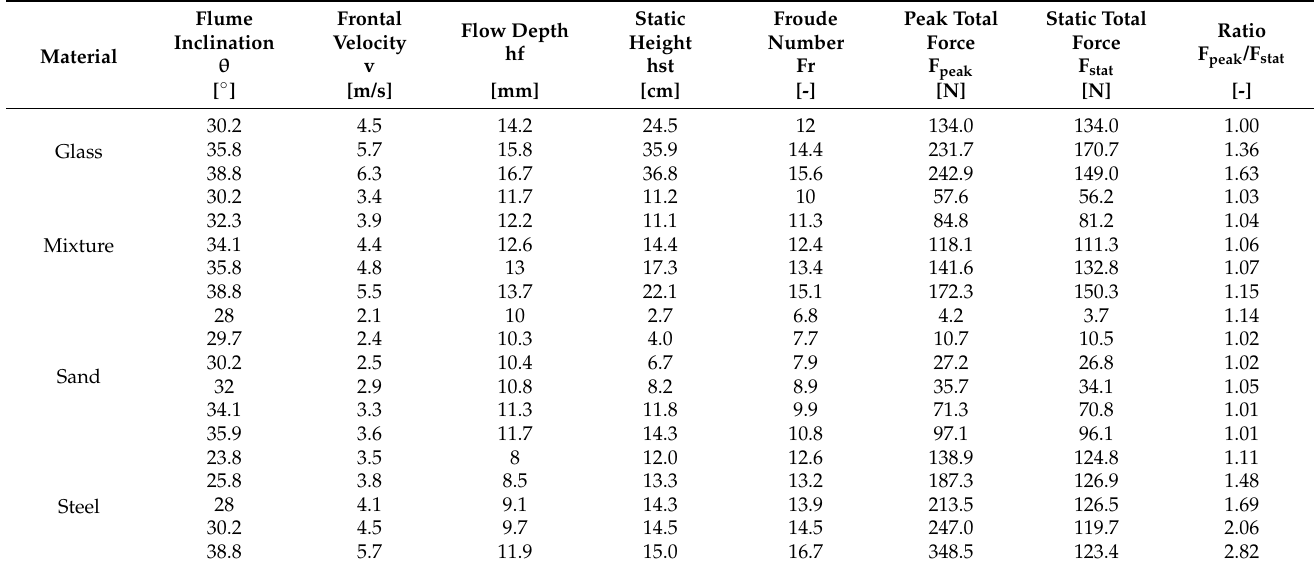
Table 5. Summary of the mean values of all test results with the flume apparatus of the University of Innsbruck for the test series on a rigid barrier.